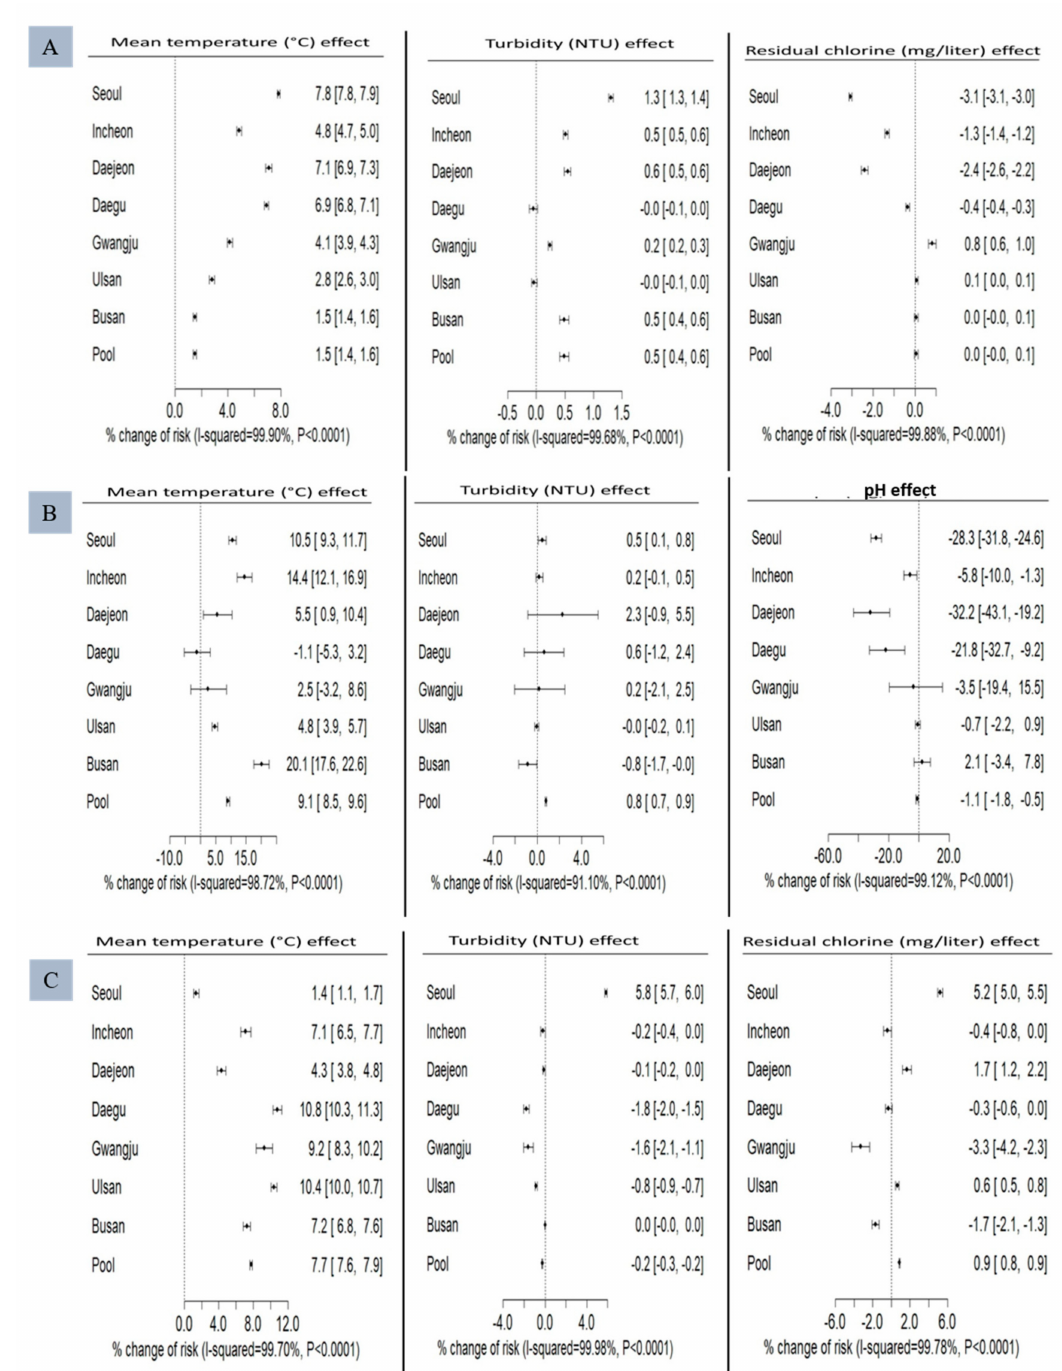
Figure 4. Percent change risk and meta-analysis for ( A ) HFMD, ( B ) AM, and ( C ) AHC cases from 2010 to 2015 in seven metropolitan provinces of Korea. HFMD: hand-foot-mouth disease, AM: aseptic meningitis, AHC: acute hemorrhagic